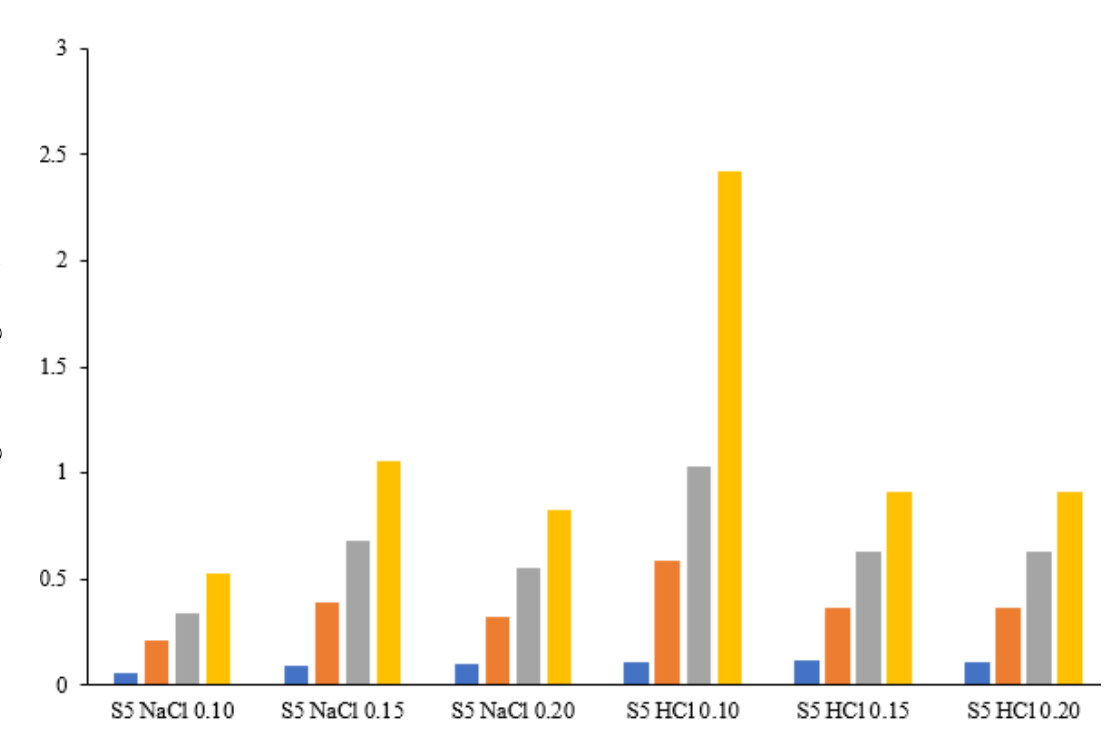
Figure 11. Effect of heat treatment on corrosion behaviour of S T5 (4%).